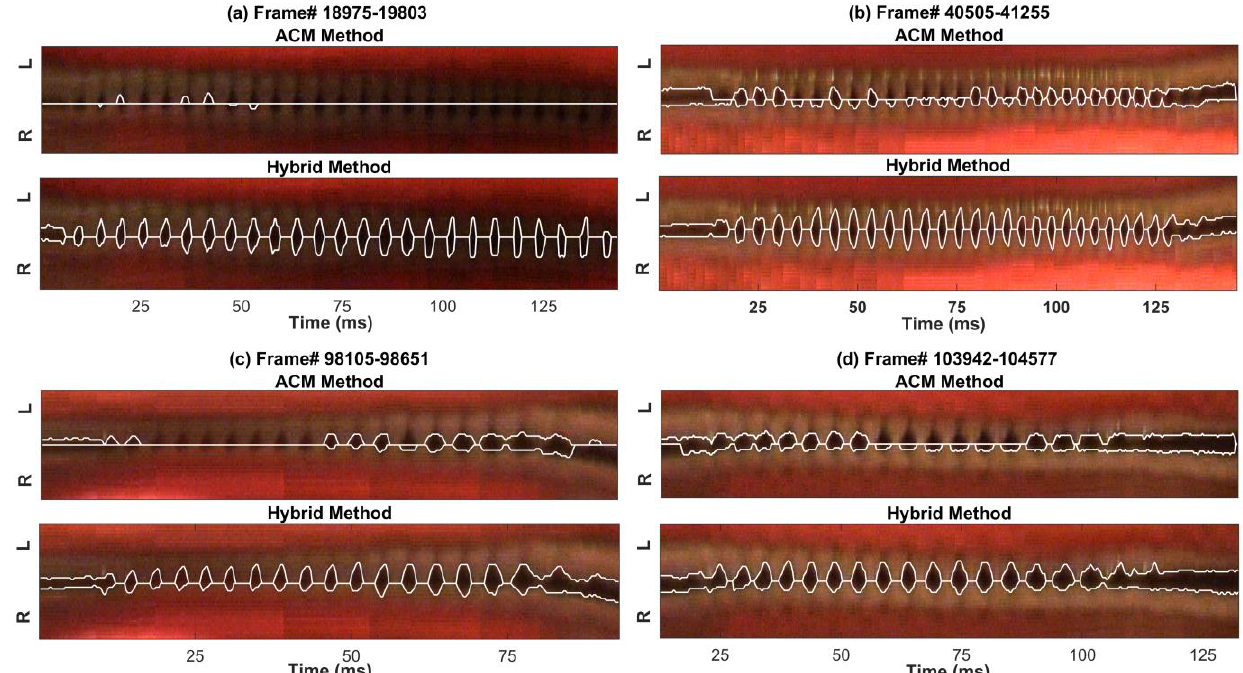
Figure 5. Detected glottal edges using the active contour modeling (ACM) method (top kymograms in Panel ( a – d )) versus the hybrid method (bottom kymograms in Panel ( a – d )) for the kymograms extracted at four different vocalizations.